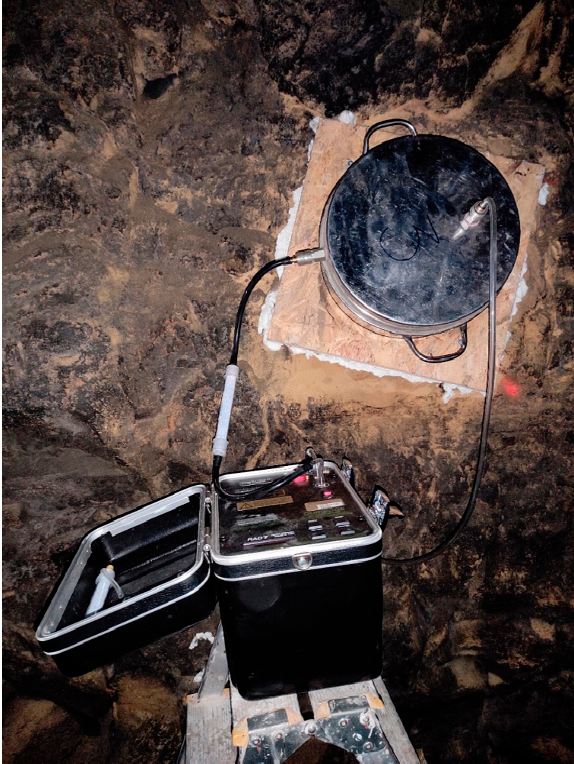
Figure 3. Measurement of radon and thoron exhalation rate in an underground gallery.